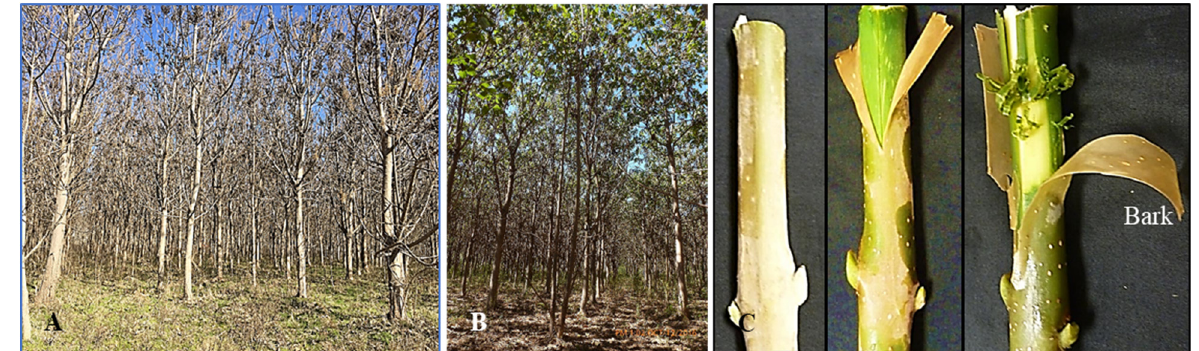
Figure 1. Six-year-old Paulownia trees growing at the ‘Paulownia Demonstration Plot’ at FVSU. Paulownia trees in dormant state during winter ( A ) and active state during spring ( B ). Cambial tissue sampling from a paulownia twig ( C ); normal branch ( left ), branch after bark removal ( middle ), and scraping wood forming cambial tissue for RNA extraction ( right ).